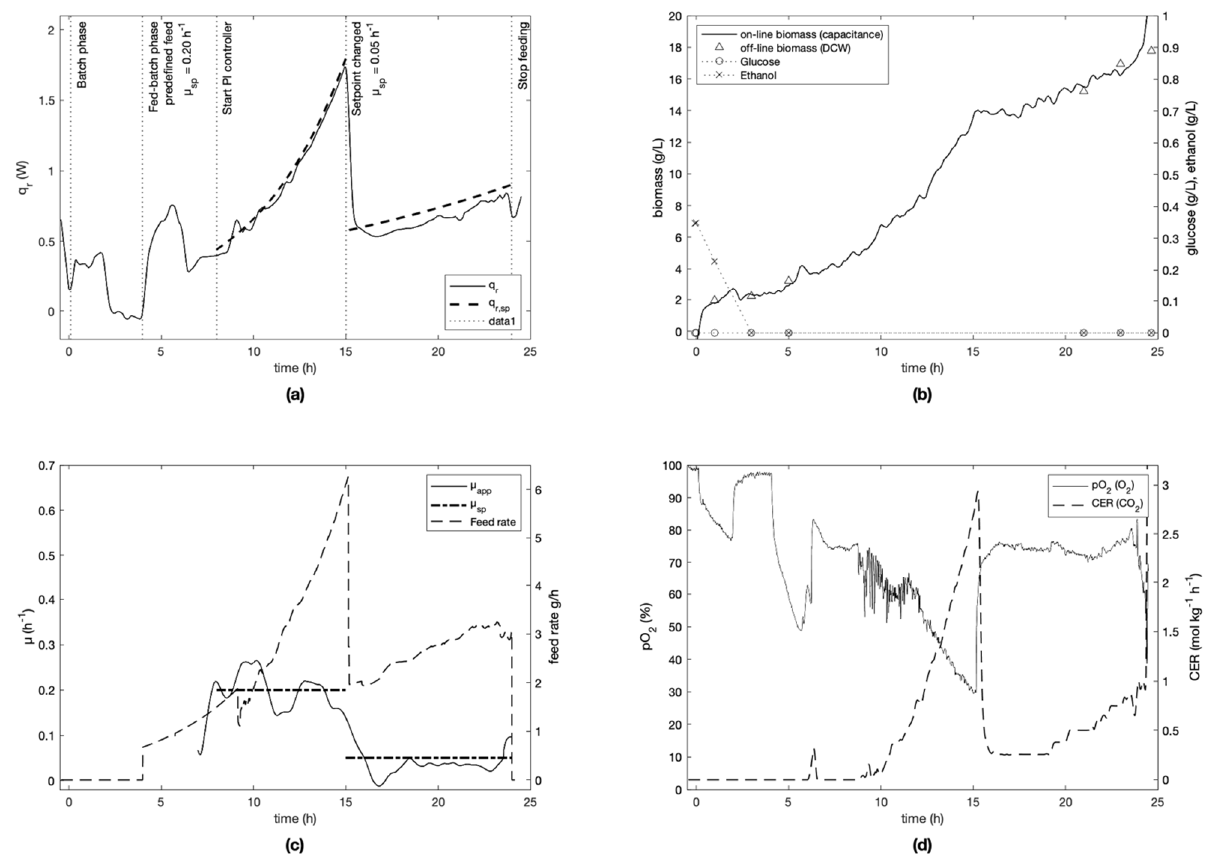
Figure 6. Fed-batch culture (E-4) of S. cerevisiae with µ sp initially set to 0.2 h − 1 and changed to 0.05 h − 1 after 15 h. ( a ) q r and q r,sp profiles. Events indicated by vertical lines. ( b ) Biomass profiles. Glucose and ethanol concentrations. ( c ) µ app from dielectric spectroscopy, µ sp and F feed . Controller MRE of 19% and 33% achieved, respectively. ( d ) pO 2 and CER.